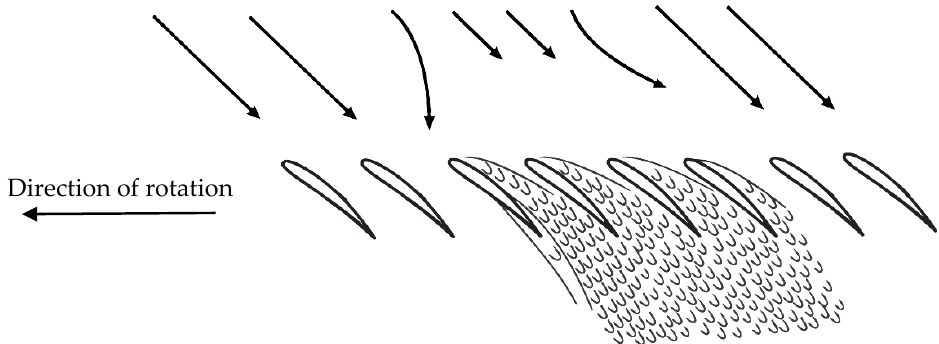
Figure 1. Stall cell formation and propagation.